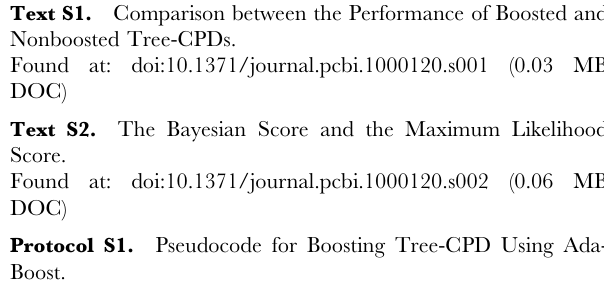
Figure S1. Summary of the Prediction Performance as a Function of the Maximal Depth of the Tree-CPD without Boosting. The depth of a tree-CPD with unconstrained maximal depth is determined automatically by the Bayesian score and the tree-CPD constructing heuristic. Standard deviation of the real data was calculated on 50 iterations of 5-fold cross validation, each time for a different division of the data to train and test sets. Standard deviation of the random models was calculated on 50 iterations of 5-fold cross validation, each time for a different shuffling of the data. Figure S2. The Prediction Performance of a Boosted Tree-CPD with Maximal Depth of 2 as a Function of the Number of AdaBoost Iterations. Standard deviation of the real data was calculated on 50 iterations of 5-fold cross validation, each time for a different division of the data to train and test sets. Standard deviation of the random models was calculated on 50 iterations of 5-fold cross validation, each time for a different shuffling of the data. Similar results are obtained for different maximal depths of tree-CPD (data not shown). Figure S3. Classifier Learned with Bayesian Score Is Less Prone to Overfitting Than Classifier Learned with Maximum Likelihood Score. Comparison between the performance on the train and test sets of tree-CPD classifier that was learned using the maximum likelihood score (left) and to that was learned using the Bayesian score (right) as a function of the maximal depth of the leaves. The performance is measured as the percentage of correctly classified examples. Standard deviation was calculated on 50 iterations of 5- fold cross validation, each time for a different division of the data to train and test sets. Table S1. Assignment of Genes to Expression Classes. Found at: doi:10.1371/journal.pcbi.1000120.s008 (0.03 MB